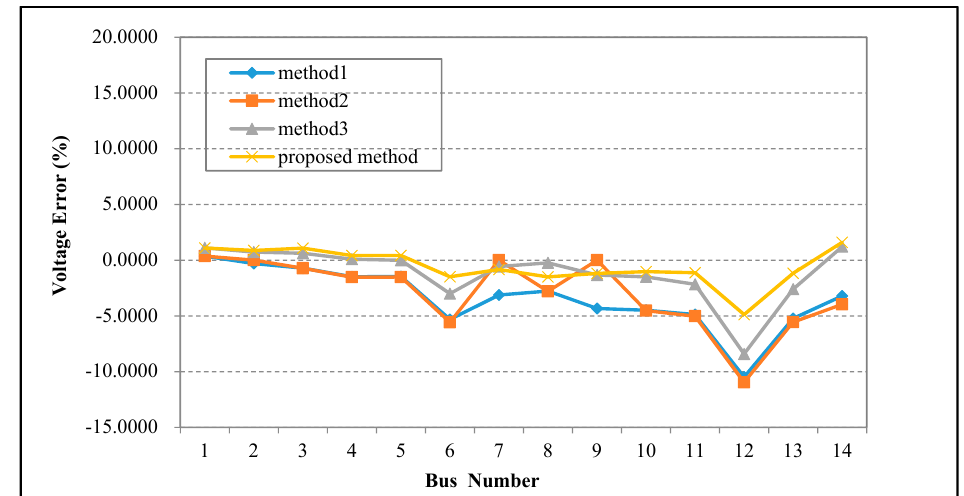
Figure 9. The percentage of bus voltage amplitude estimate error in 14 bus system.